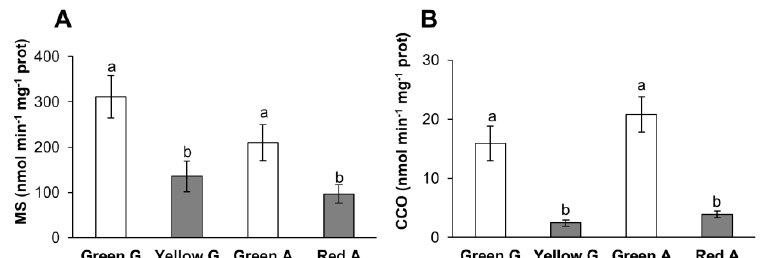
Figure 6. Enzymatic specific activity of ( A ) malate synthase (MS) and ( B ) cytochrome c oxidase (CCO) in green Galena (G), yellow Galena, green Alonso (A), and red Alonso pepper fruits. Data are means ± standard error (SE) of three technical replicates of three biological samples. Different lower case letters indicate that data are significantly different according to the Kruskal-Wallis test at p < 0.05.